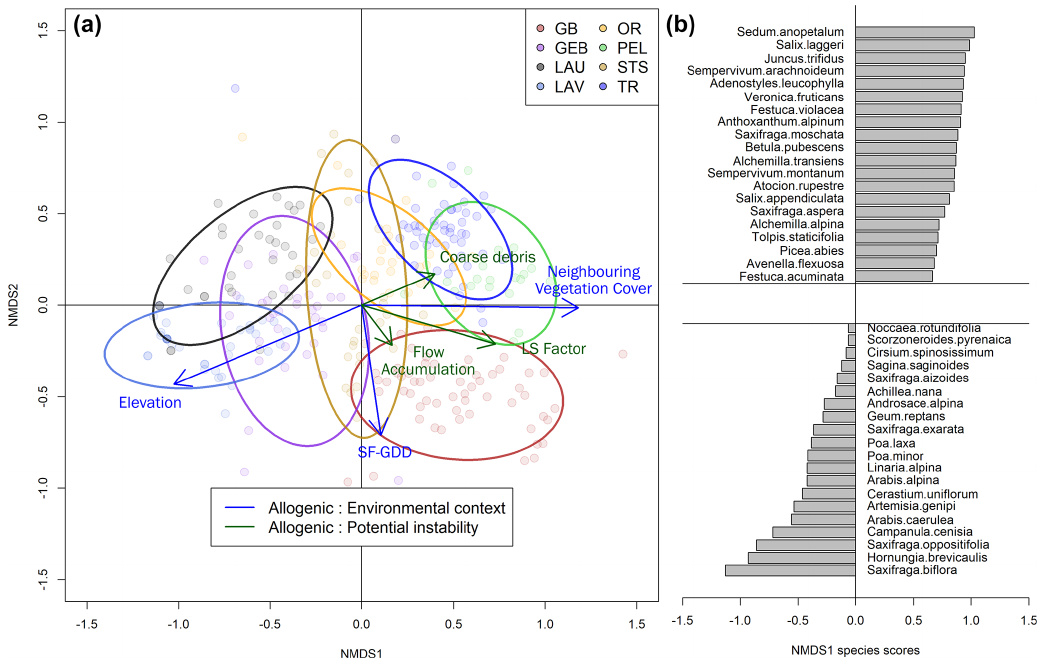
Figure 8. (a) Non-metric multidimensional scaling (NMDS) of floristic plots by species with vector fitting of explanatory variables imple- mented using generalized least-squares (GLS) regression corrected for autocorrelated error structure. Ellipsoids correspond to an interval of 0.8 the standard deviation. The analysis includes 297 plots from the eight glacier forefields. (b) Species distribution along the NMDS first axis, with the 20 species depicting the highest and lowest scores.